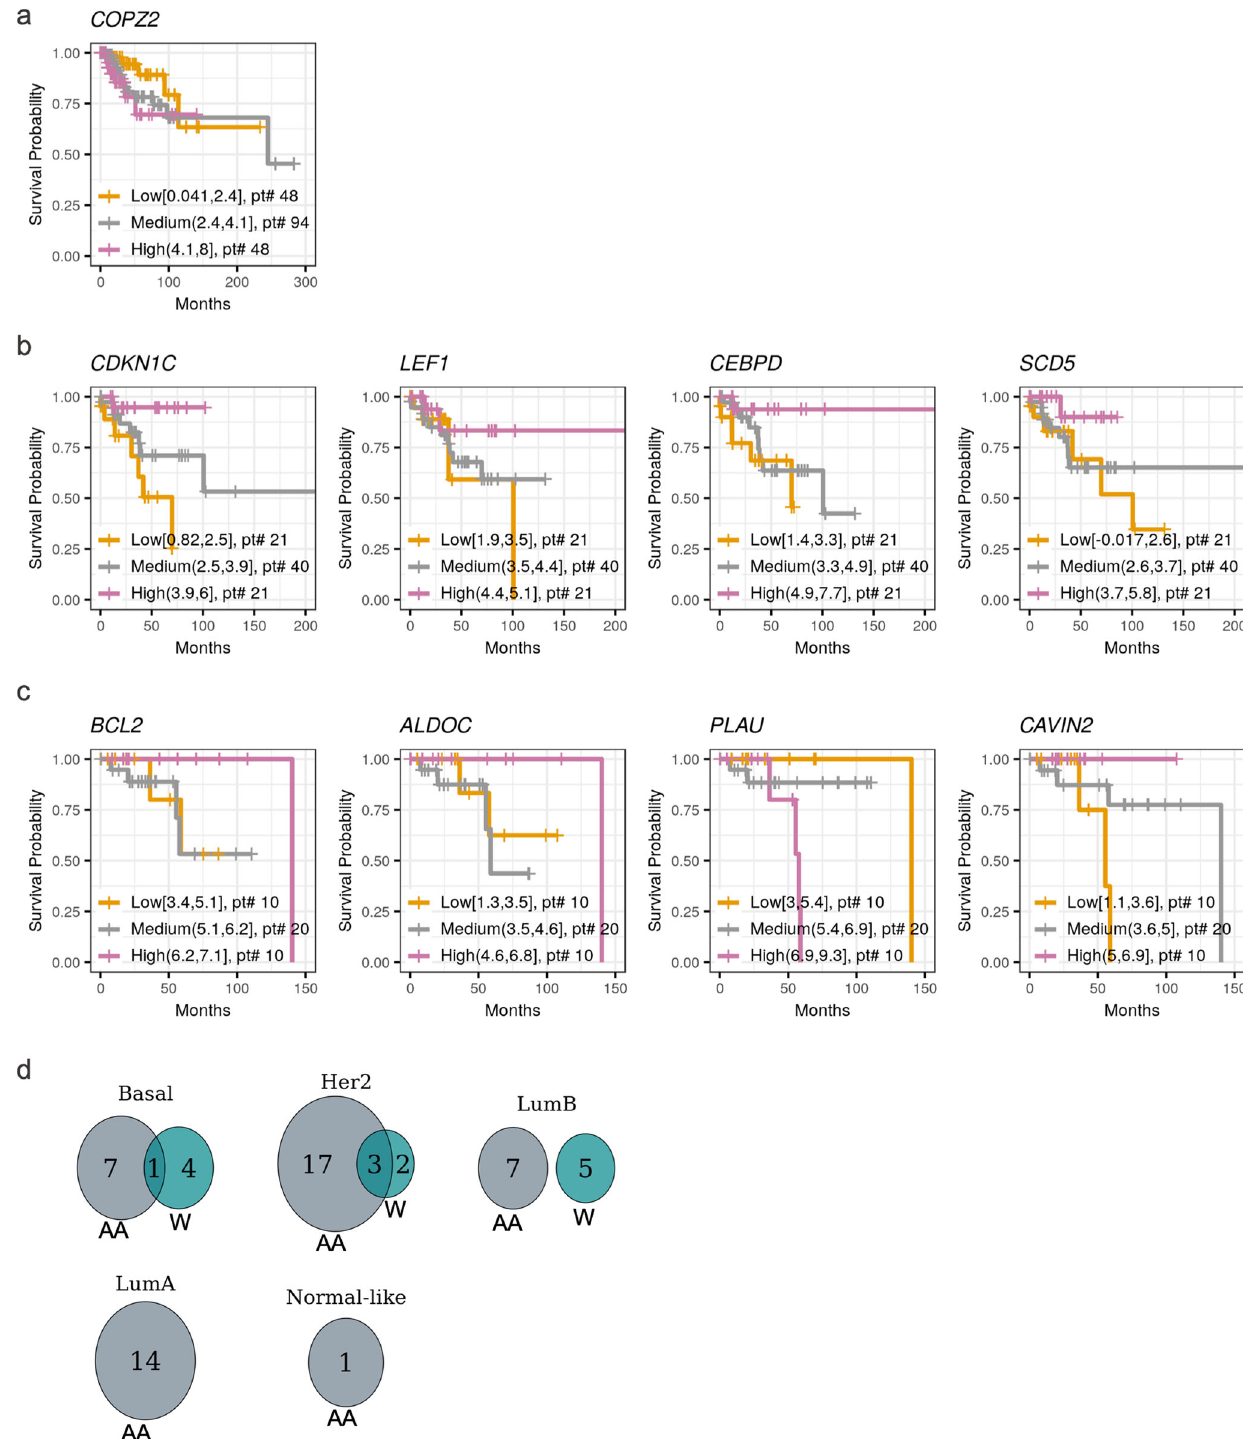
Fig. 6 Survival analysis of the DE-SN. Kaplan – Meier plots for the DE-SN depicting the association of DE-SN level in Basal ( a ), Her2 ( b ), and Normal-like ( c ) with breast cancer patient overall survival probability. The DE-SN exhibit HR > 1.5 or < 0.58 and p -value < 0.05. The survival probabilities were compared in breast cancer patients of indicated PAM50 subtypes expressing high, low, or intermediate (75th, 25th, or 25th – 75th percentiles) levels of the indicated DE-SN The number of patients (pt#) of high, low, or intermediate groups are indicated. d Venn diagrams showing the number of DE-SN associated with AA or W breast cancer patient overall survival probability in the indicated PAM50 subtypes.